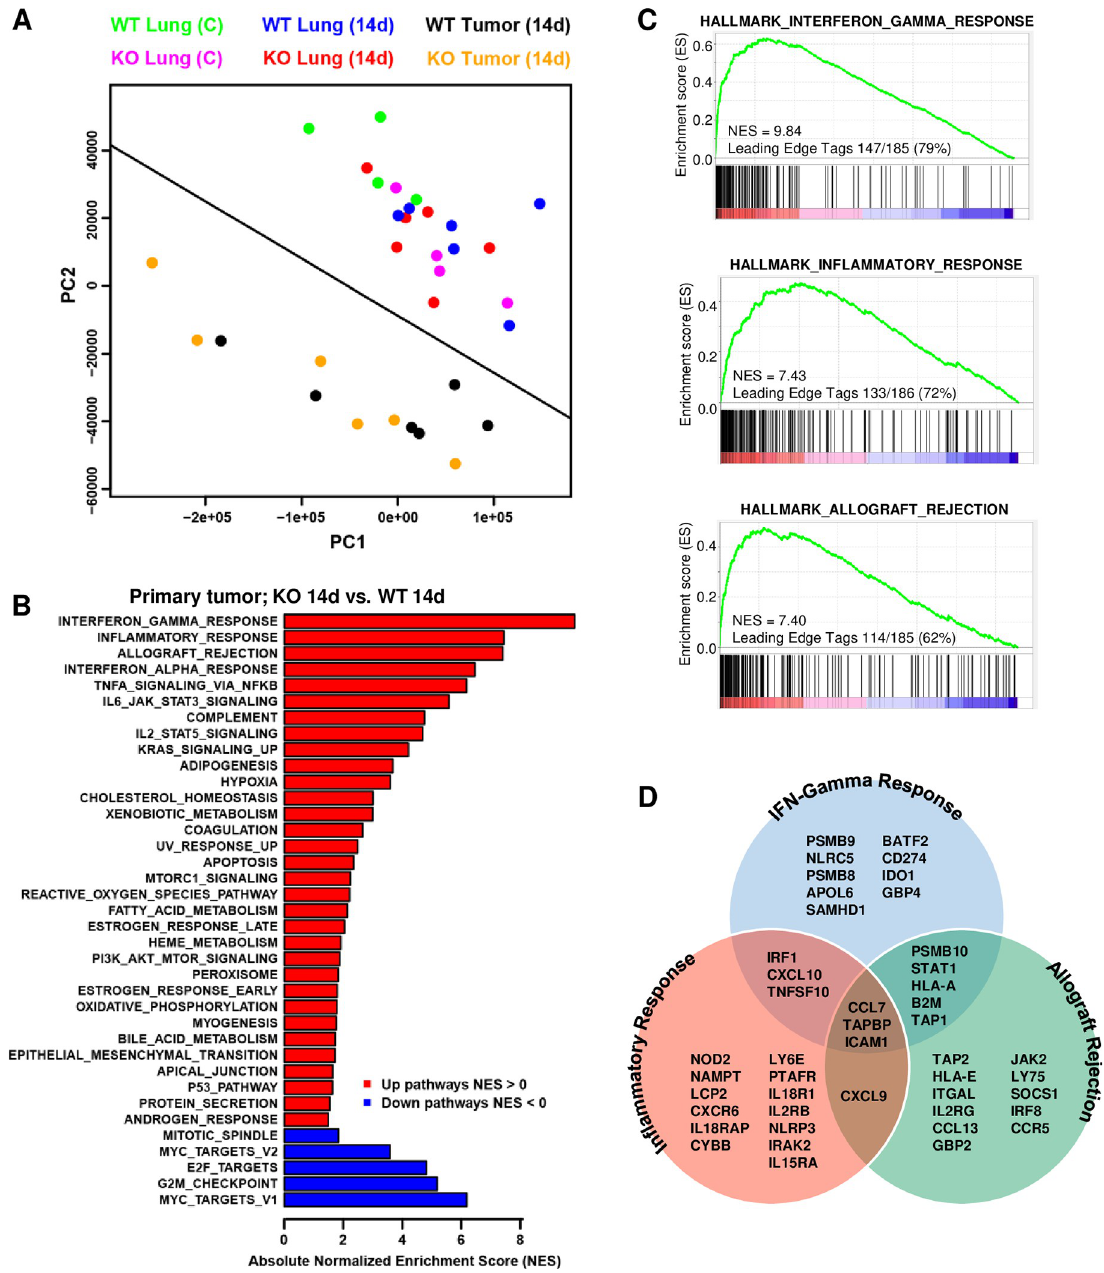
Fig 7. RNA-seq analysis reveals that host genotype determines the transcriptome of primary tumors implanted for 14 days. ( A ) Principal component analysis (PCA) of n = 32 RNA-seq samples from normal WT and KO lungs (n = 8), lungs from WT and KO tumor- bearing mice (n = 12), and primary tumors from WT and KO mice (n = 12) at 14 days post-implantation shows separation of samples based on tissue of origin but not genotype. ( B ) Gene set enrichment analysis (GSEA) interrogated MSigDB Hallmark gene sets to determine if genes differentially expressed between KO and WT tumors were significantly enriched in distinct biological pathways. Only significantly (FDR < 0.1) upregulated (red) and downregulated (blue) pathways are shown, represented by absolute normalized enrichment score (NES). ( C ) Representative enrichment plots of the top three upregulated pathways show the frequency of leading-edge genes contributing to the NES. ( D ) Venn diagram showing the overlap between the first 20 leading-edge genes from the top pathways upregulated in KO tumors, Interferon-Gamma Response, Inflammatory Response, and Allograft Rejection.